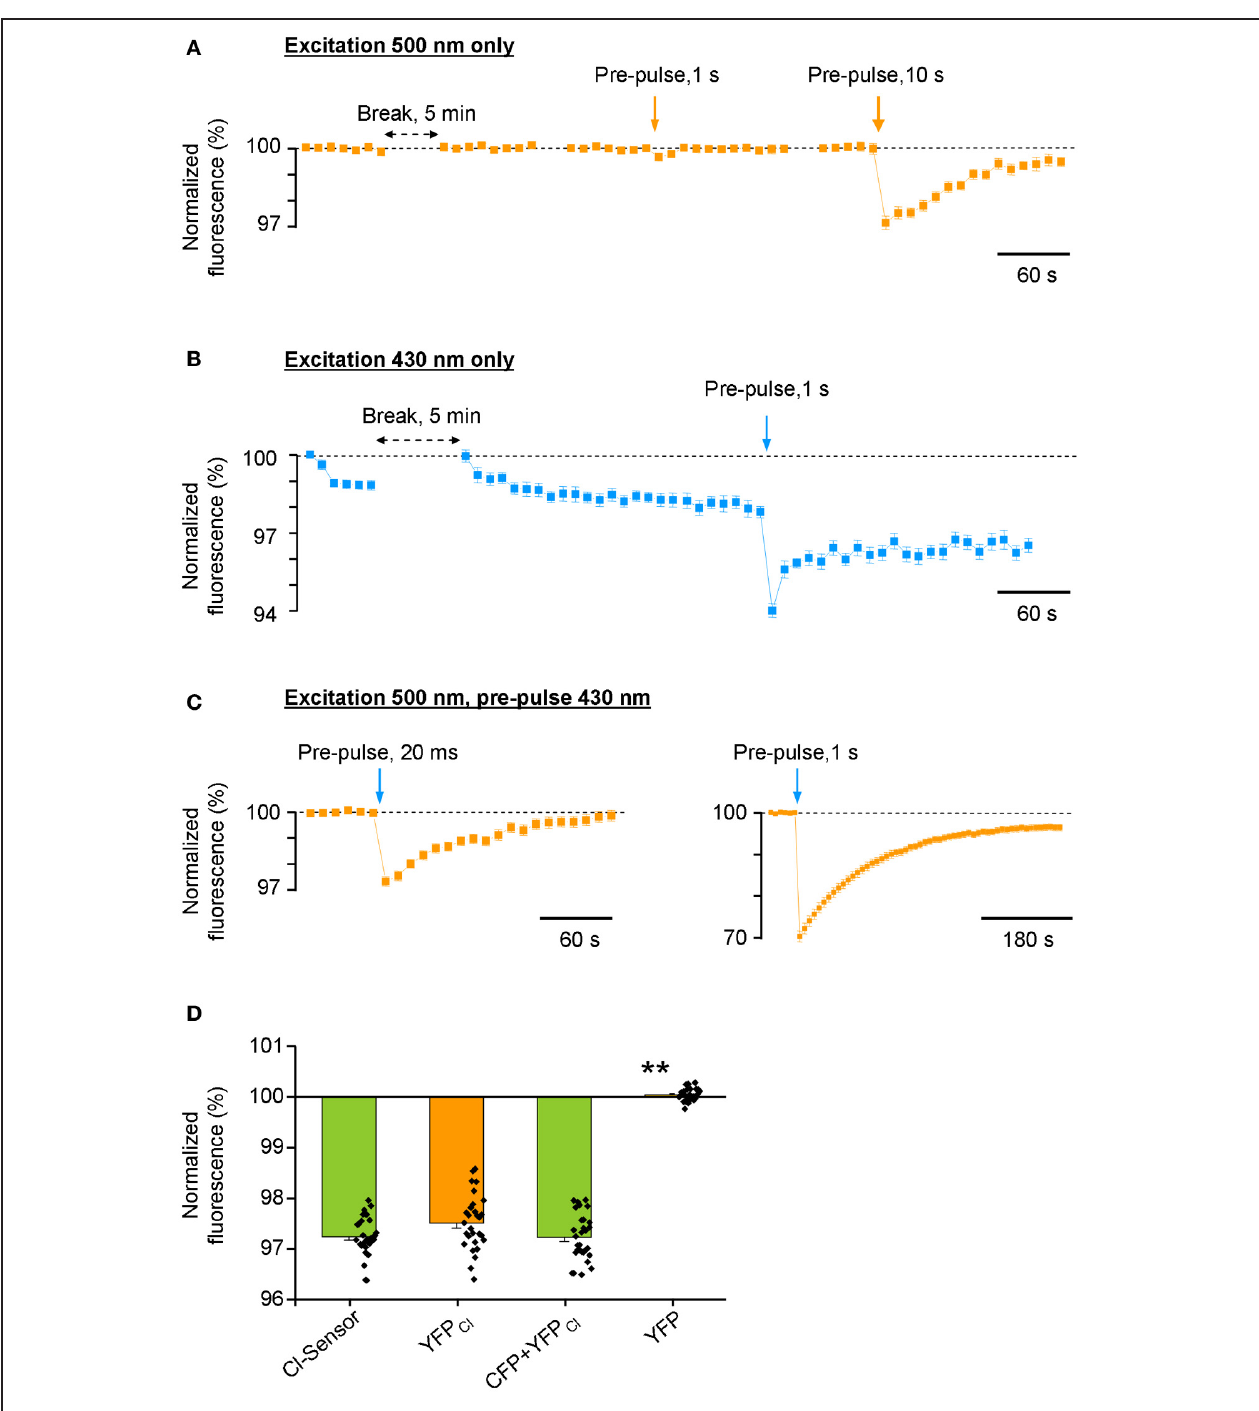
FIGURE 3 | Differential photoinactivation of CFP and YFP components of Cl-Sensor. All responses shown in the figure are mean ± SEM values from 40 to 43 cells visualized in a single optical field. Similar data were observed in 8 other experiments. In all depictured experiments, the duration of test excitation was 20 and 50ms through 430 or 500nm filters, respectively. The interval between acquisitions was 10s (unless otherwise indicated with horizontal double head arrow). (A) Fluorescence responses of Cl-Sensor to repetitive excitations through a 500nm filter. Vertical arrows show moments of Cl-Sensor excitation with additional light pulses through the same filter.